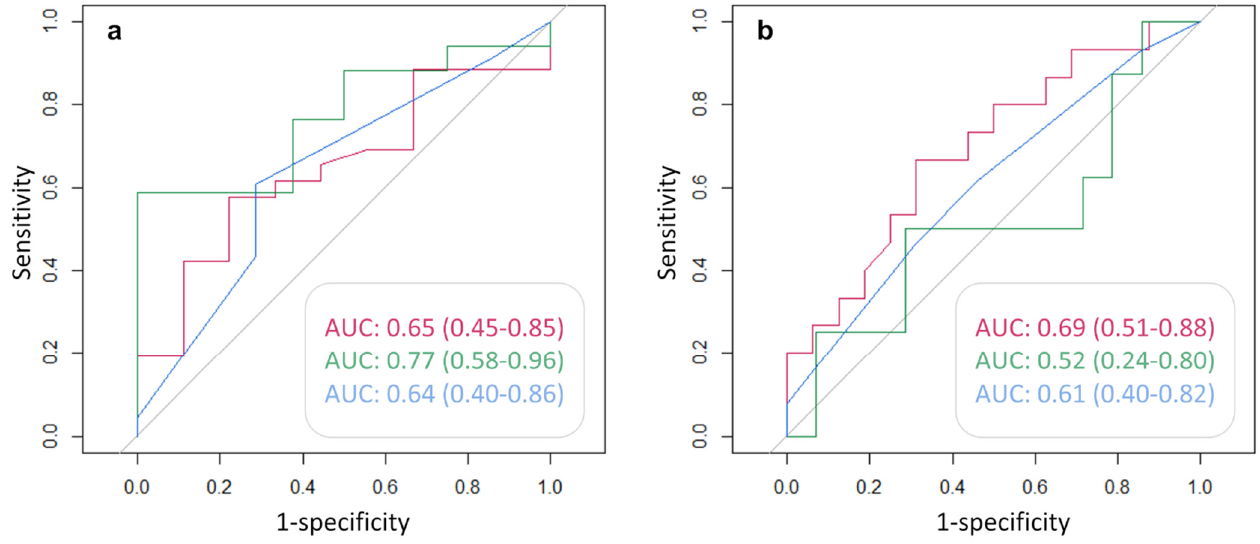
Figure 6. ROC analysis for the prediction of ( a ): 68 Ga-PSMA and ( b ): 68 Ga-DOTA-RM2 PET positive findings. Red line: AUC of PSA at time of scans in the prediction of PET positivity; green line: AUC of PSA DT in the prediction of PET positivity; blue line: AUC of GS prior to radical treatment in the prediction of PET positivity. AUC and 95% CI are here reported.